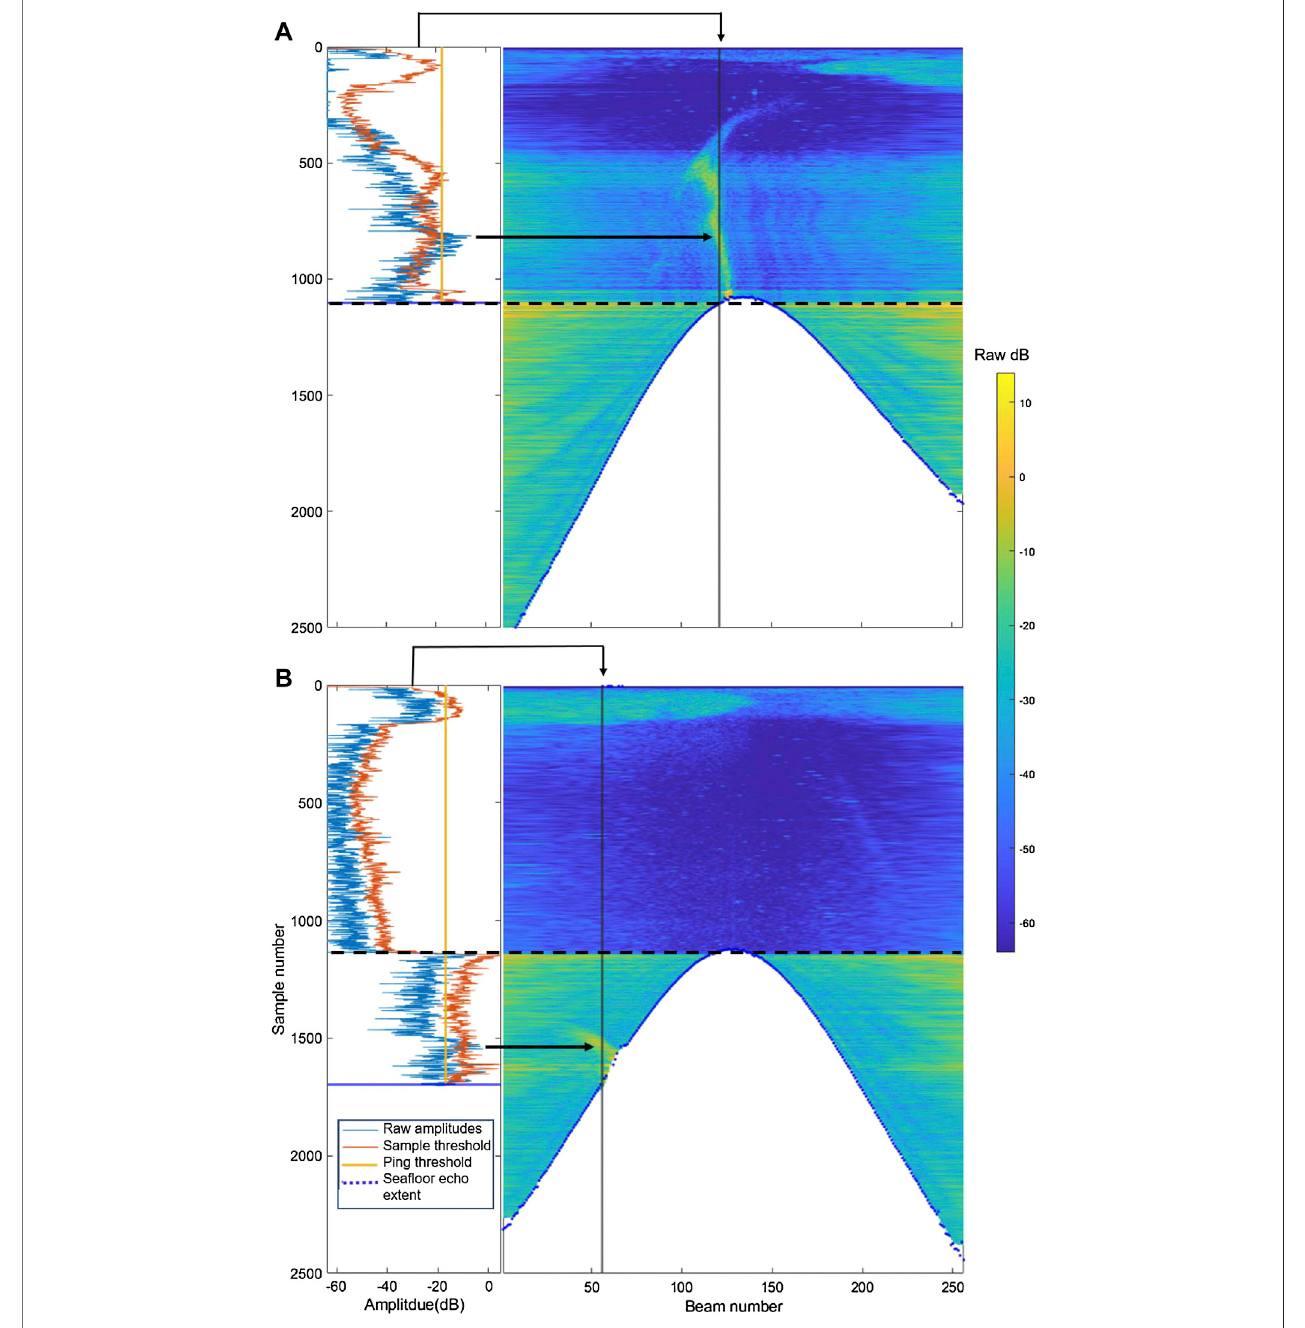
FIGURE4| ExampleofrawWCDamplitudesplottedwiththe fi lteringthresholds foraseeplocated (A) nearnadirand (B) withintheouterbeamsfullywithinMSR B. ThegraphsontheleftshowaplotoftherawWCDamplitudes(lightblueline)forthebeamindicatedbytheverticalblacklineonthecorrespondingimageontheright.The orange line is the sample range threshold, with a different threshold value for each sample range. The yellow line is the ping threshold, with a single value for all samples andbeamsforthatping.Anypartofthebluelinethatistotherightofboththeorangeandyellowthresholdsatthatsamplerangewillberetainedbythe fi ltering.Any data to the left of the thresholds will be rejected. The black arrows indicate the seep, which has amplitudes above (right) of both thresholds. The black dashed lines indicate the transition between the MSR A and MSR B data. Note the lack of this transition in (A) as the plotted beam falls fully within MSR A . The color scale for the right images is raw amplitude in dB and corresponds to the X-axis of the plots on the left.